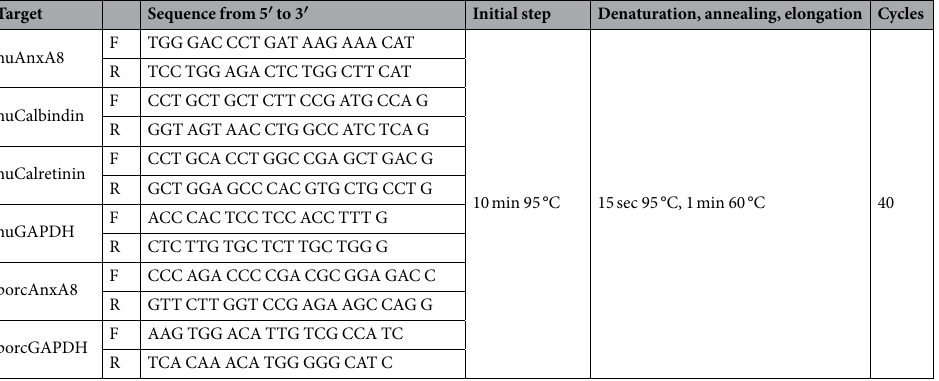
Table 2. Human and porcine primer pairs used for real-time PCR. Shown are the forward (F) and reverse (R) sequence of the primers, as well as PCR